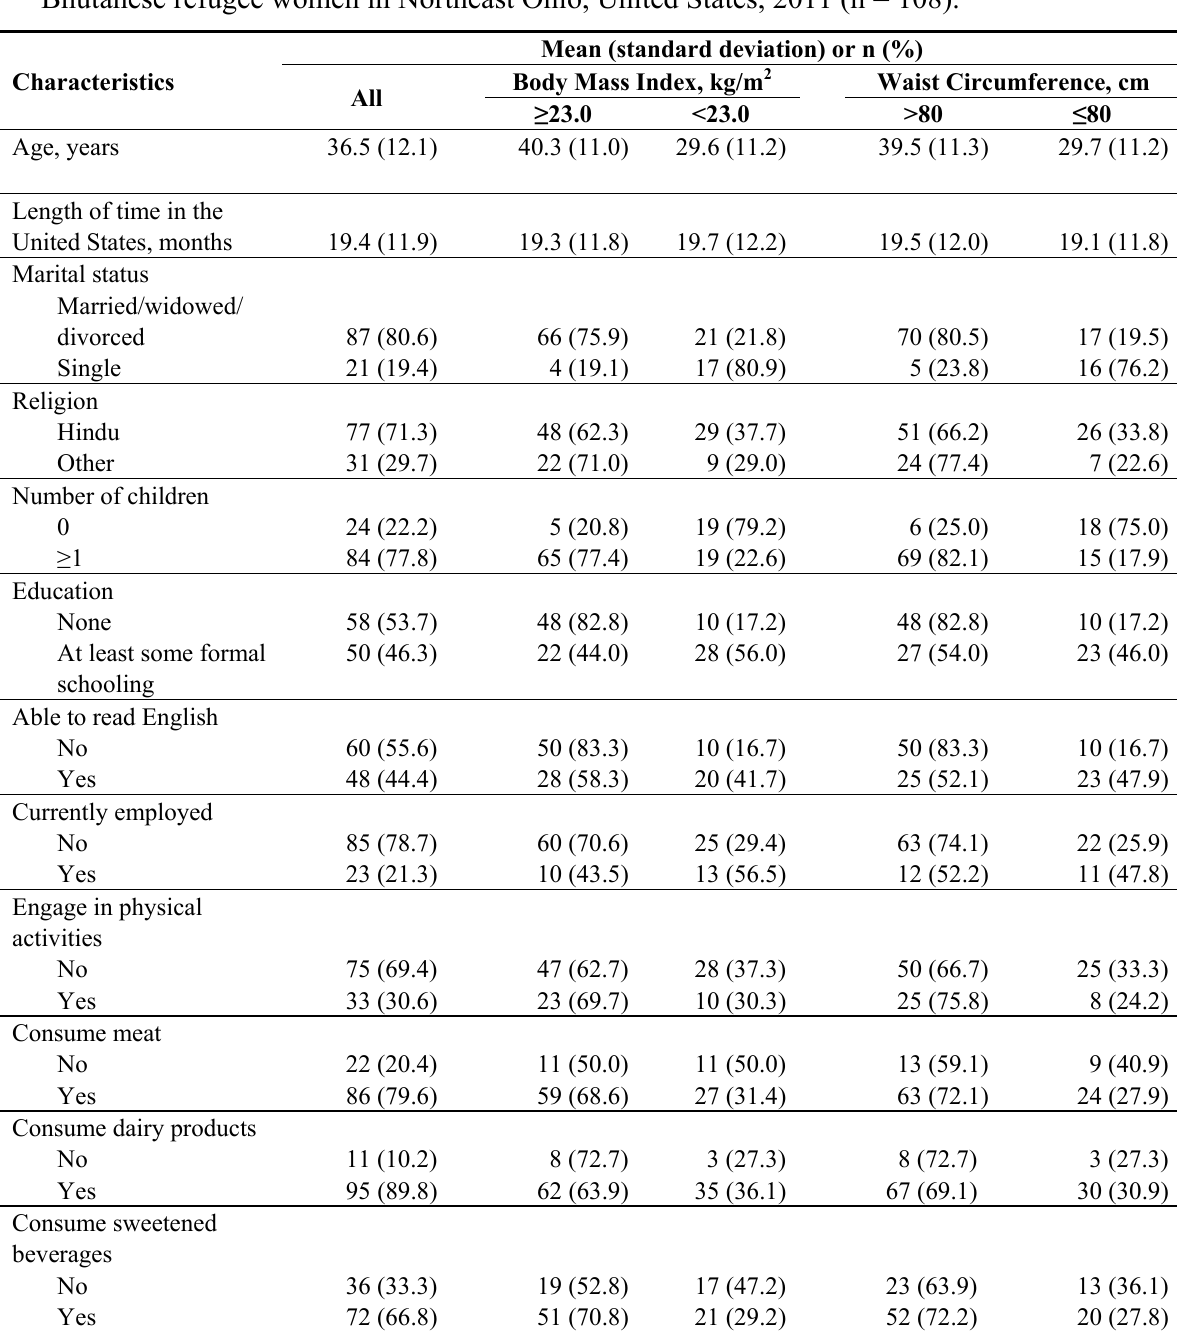
Table 1. Socio-demographic characteristics and dietary practices among 18–65 year old Bhutanese refugee women in Northeast Ohio, United States, 2011 (n = 108).